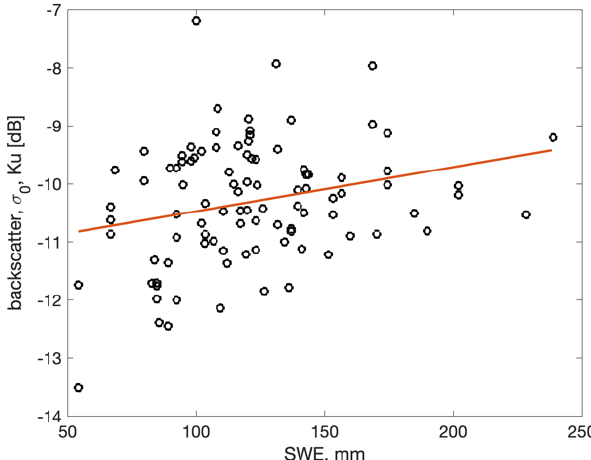
Figure 17. Two-dimensional plot of σ 0 against the single variable of SWE at Ku-band. The line represents a least-squares linear fit between the two